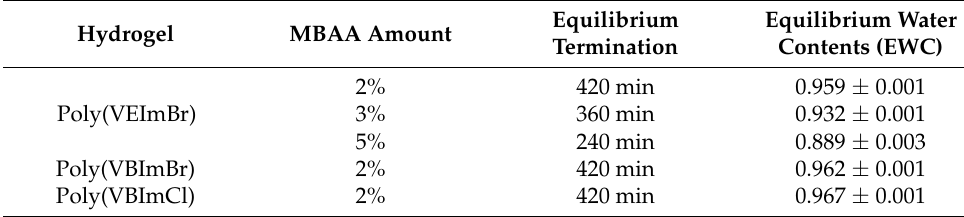
Table 3. Equilibrium water contents of pILs-based